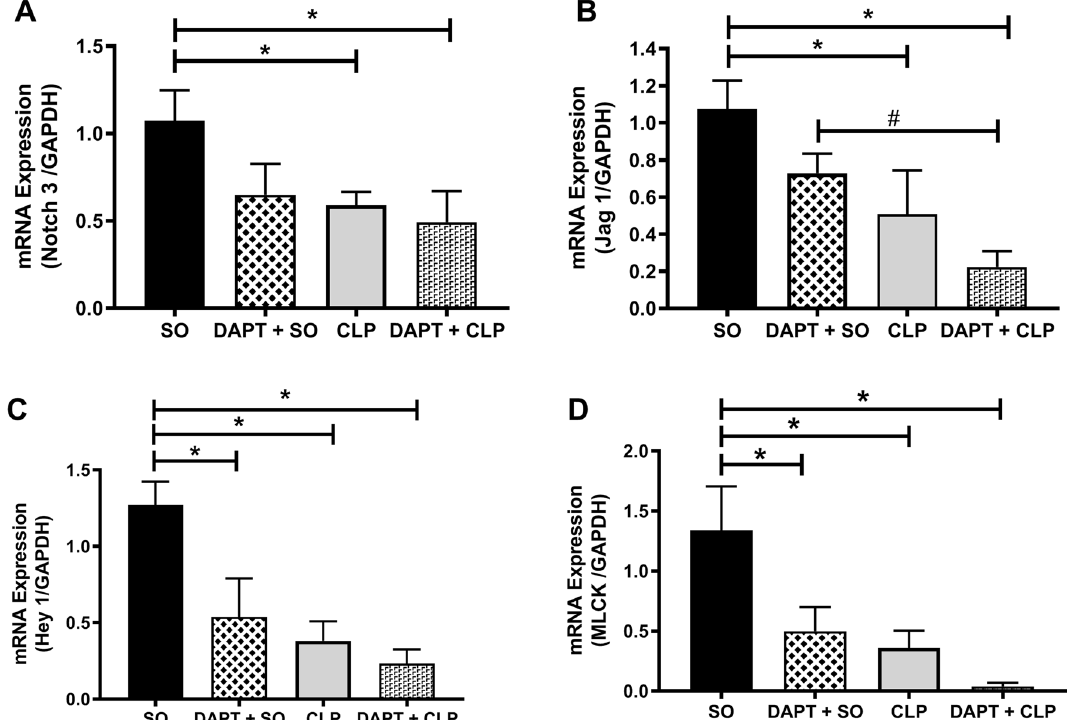
Figure 6. Effect of DAPT treatment on comparative aortic Notch signaling and its effector genes. Bar diagrams showing the effect of in vivo treatment with DAPT, a selective inhibitor of γ-secretase, on mRNA expression of Notch3 receptor ( A ), Jag1 ligand ( B ), Hey1 ( C ) and MLCK ( D ) genes in the aorta of SO and CLP mice. SO sham-operated, CLP sepsis. Data are presented as mean ± SEM. Vertical bars represent SEM; n = 7–8. Data were analyzed by one-way ANOVA followed by Tukey’s post-hoc test. * p < 0.05 vs. SO, # p < 0.05 vs. DAPT + SO.